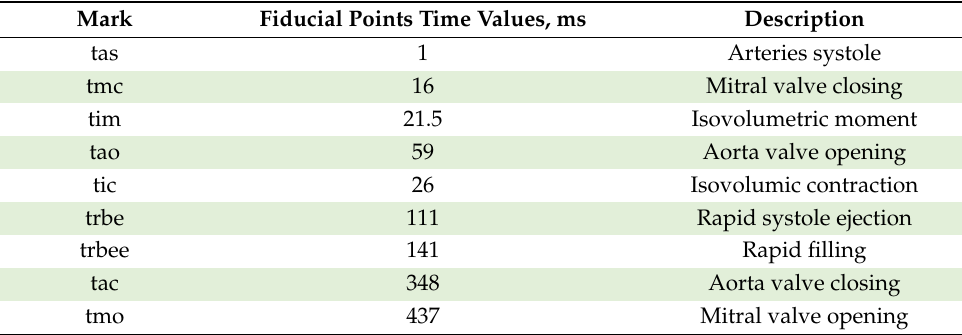
Table 3. Modeled SCG signal fiducial points time values and